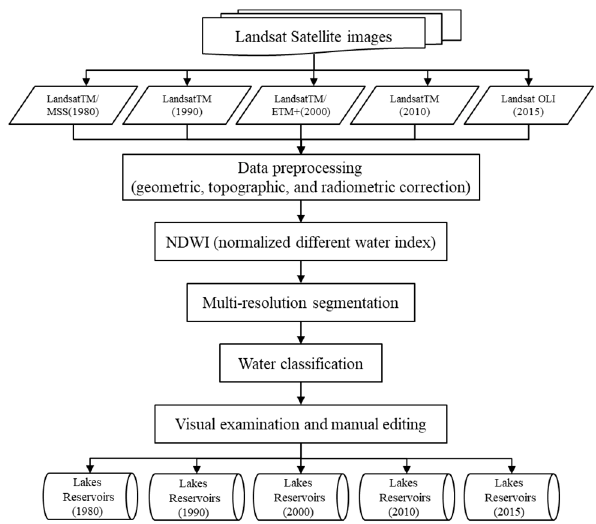
Figure 3. Flowchart for the lake and reservoir mapping process.